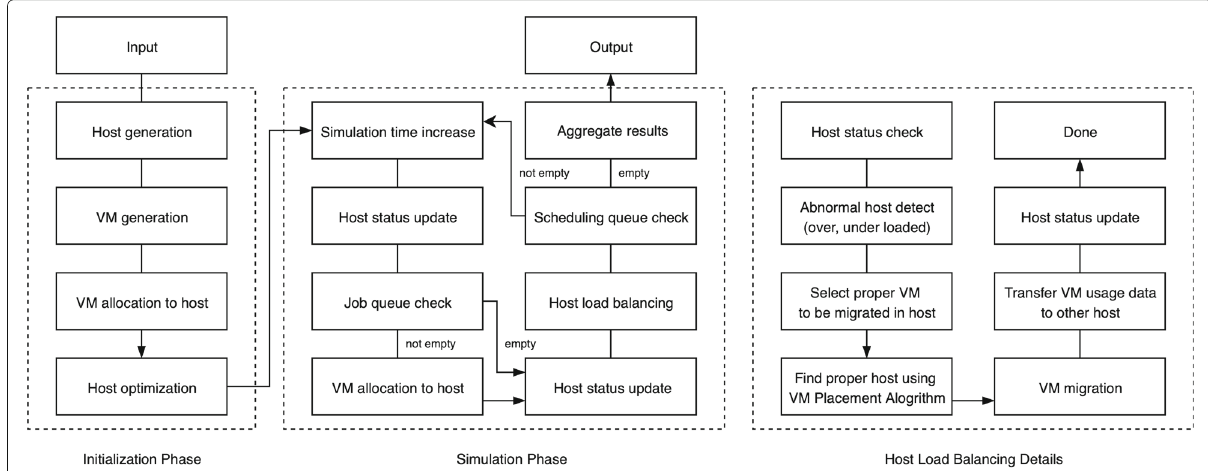
Fig. 5 Experiment Workflow